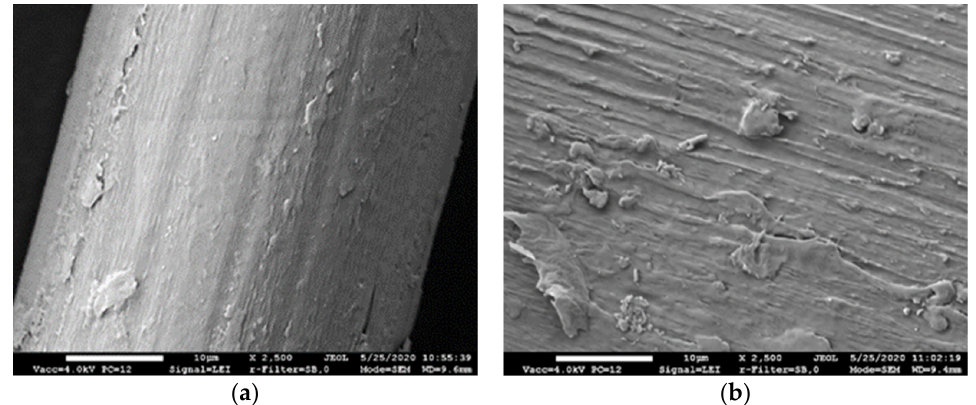
Figure 1. Surface of PVA fiber: ( a ) PVA fiber of Type A; ( b ) PVA fiber of Type B. The superplasticizer Melment F10 (SP) (BASF Construction Polymers GmbH, Trotsberg, Germany) used for the mixtures is a free-flowing spray dried powder of a sulphonated polycondensation product based on melamine. It has a pH value of 9.4 at 20 ◦ C temperature in 20% solution. Tap water was used for the mixtures. Compositions of cement paste for XRD, DTG, MIP analysis and lightweight composite used in the tests described in this paper are presented in Table 5. Table 5. Compositions of cement paste and lightweight composite (% by mass).